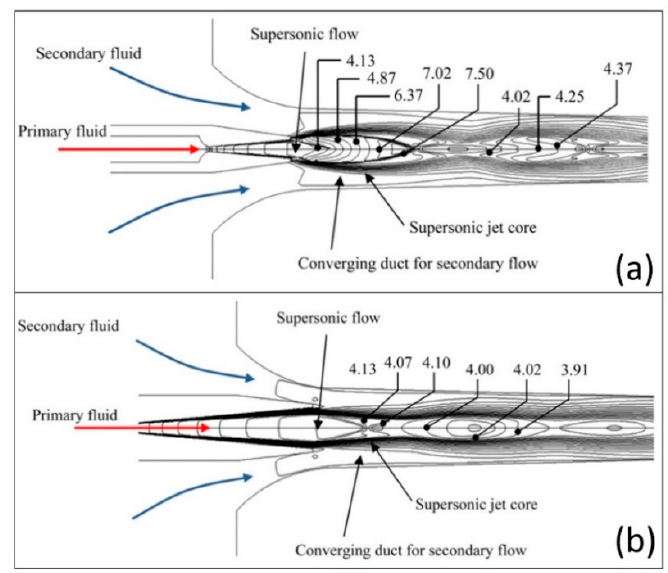
Figure 20. Effects of the expansion wave at the nozzle exit on the secondary flow: ( a ) jet under-expanded; ( b ) jet over-expanded [82].